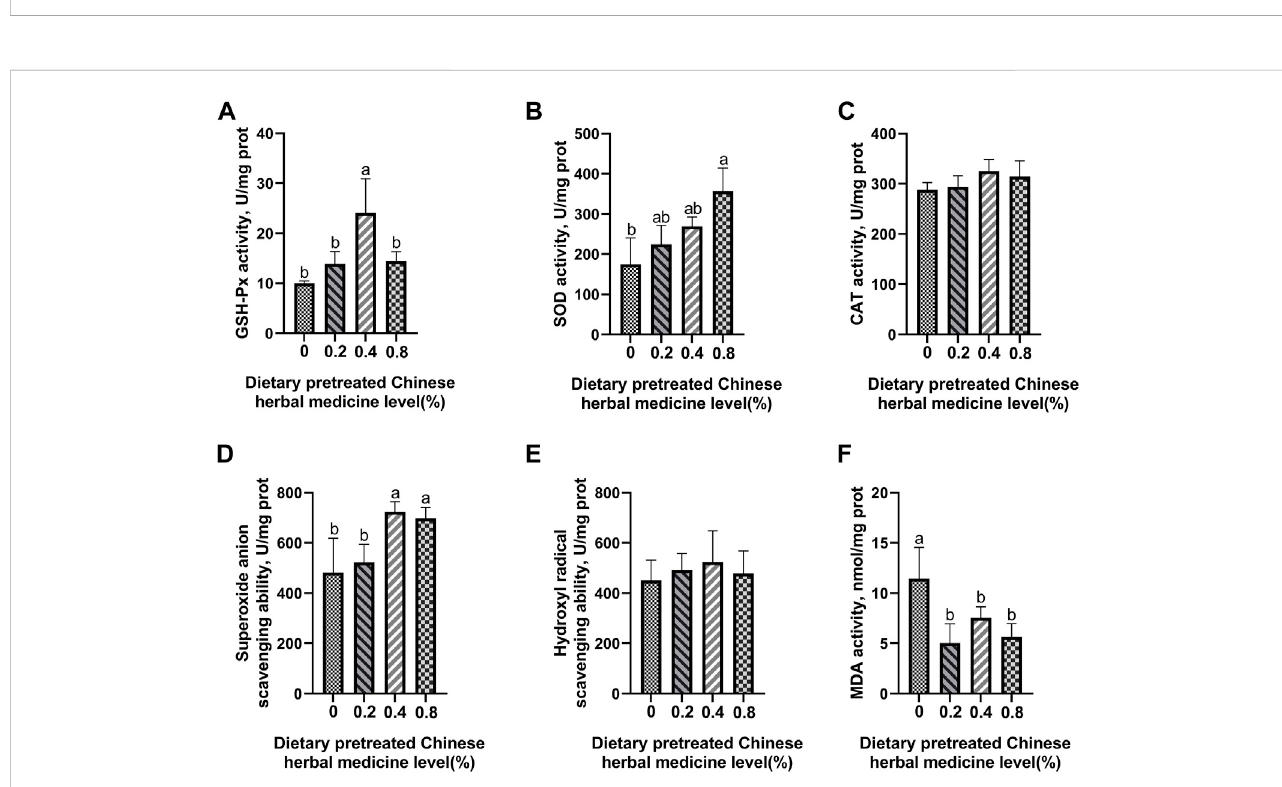
FIGURE 4 EffectofdietaryPCHMsupplementationontheantioxidantenzymeactivityandfreeradicalsinthemagnumoflate-phaselayinghens. (A – C) Glutathione peroxidase (GSH-Px), superoxide dismutase (SOD), and catalase (CAT) activity in the magnum. (D,E) Scavenging free radical abilities in the magnum. (F) Malondialdehyde(MDA)levelinthemagnum.Valuesareexpressedasmeans±SEMofsixbirdspertreatment.Meanswithoutacommonletterdiffer( p < 0.05).